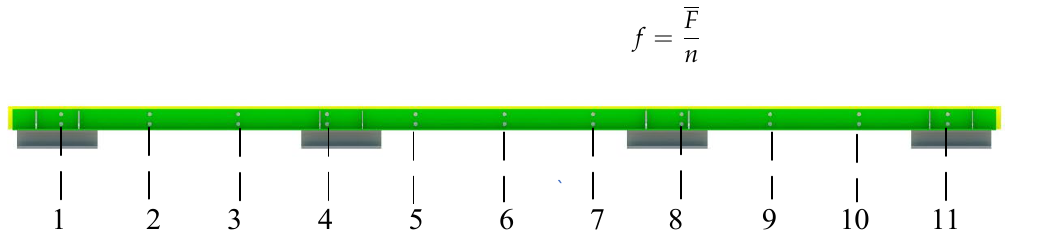
Figure 17. Area division of the angle steel of friction energy dissipation composite chord.